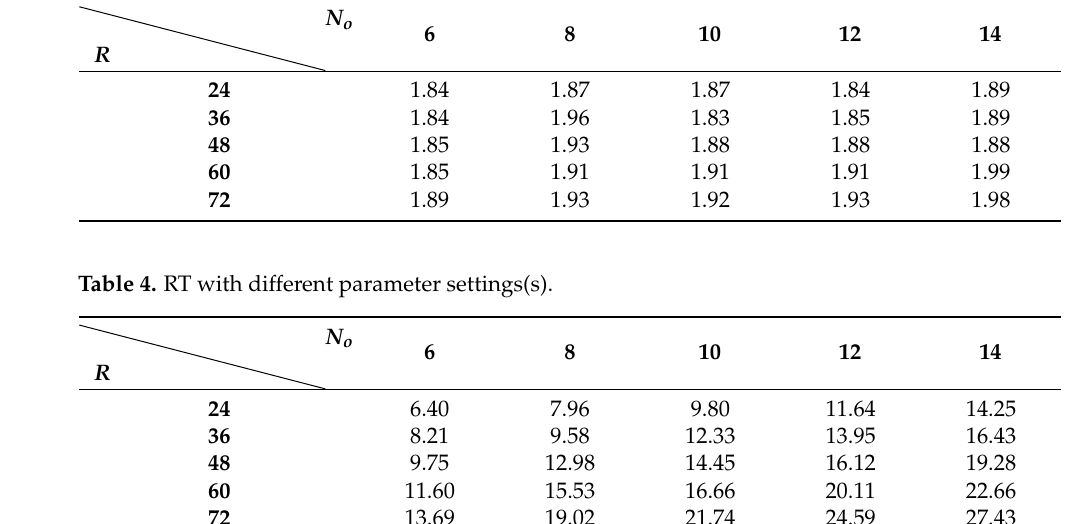
Table 3. RMSE with different parameter settings (pixels).